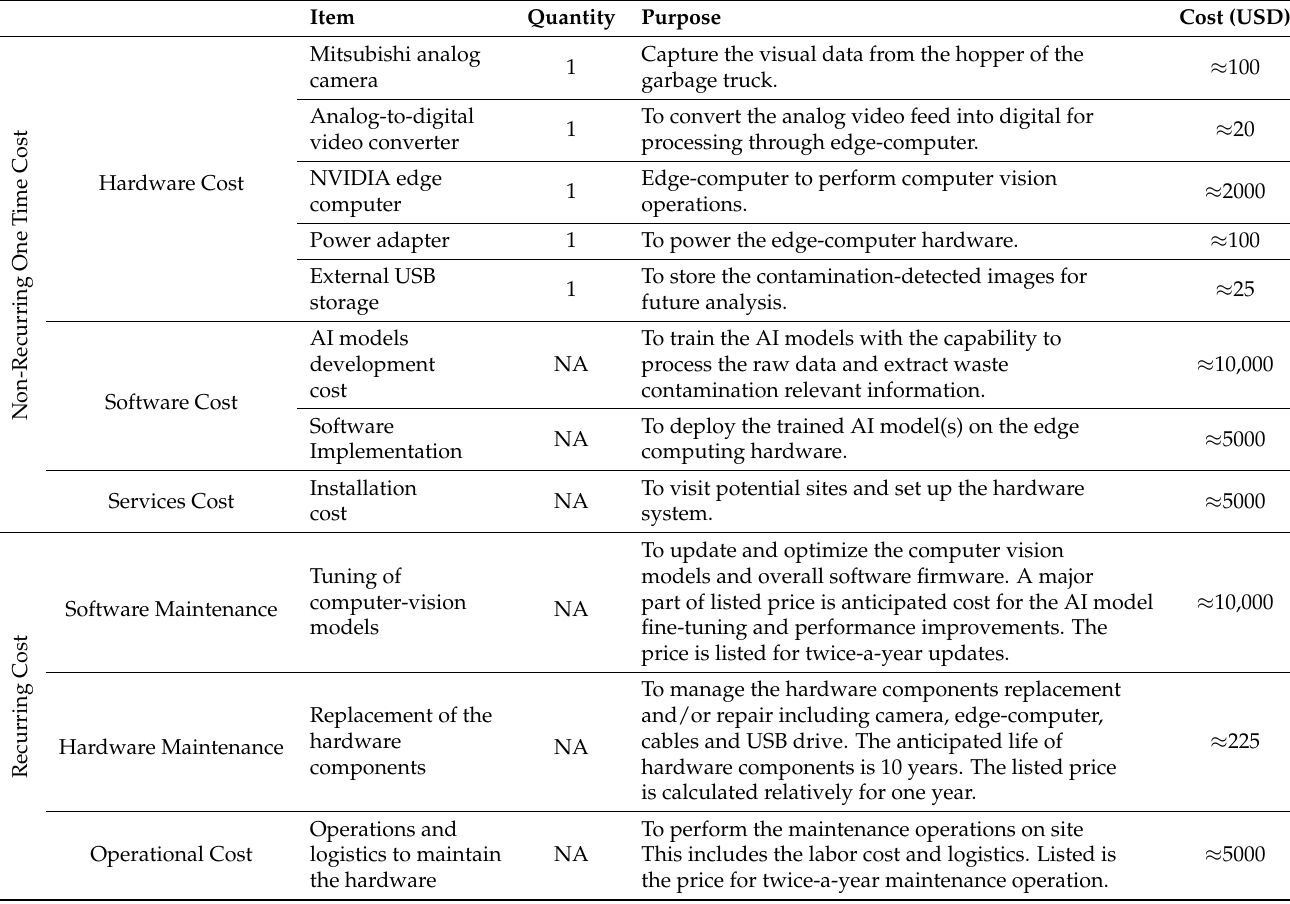
Table 8. Detailed cost analysis for proposed plastic-bag contamination detection